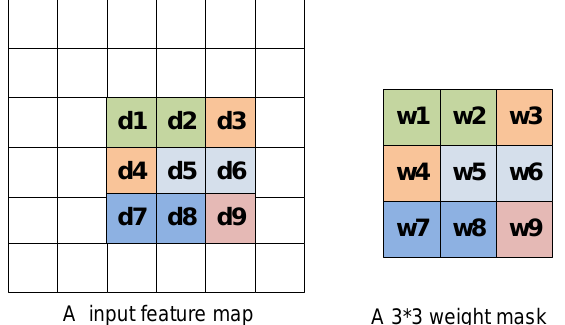
Figure 3. A parallel data fetch